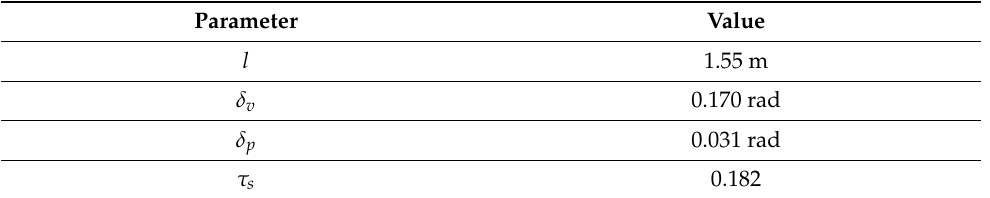
Table 1. Results obtained in the Ackermann steering